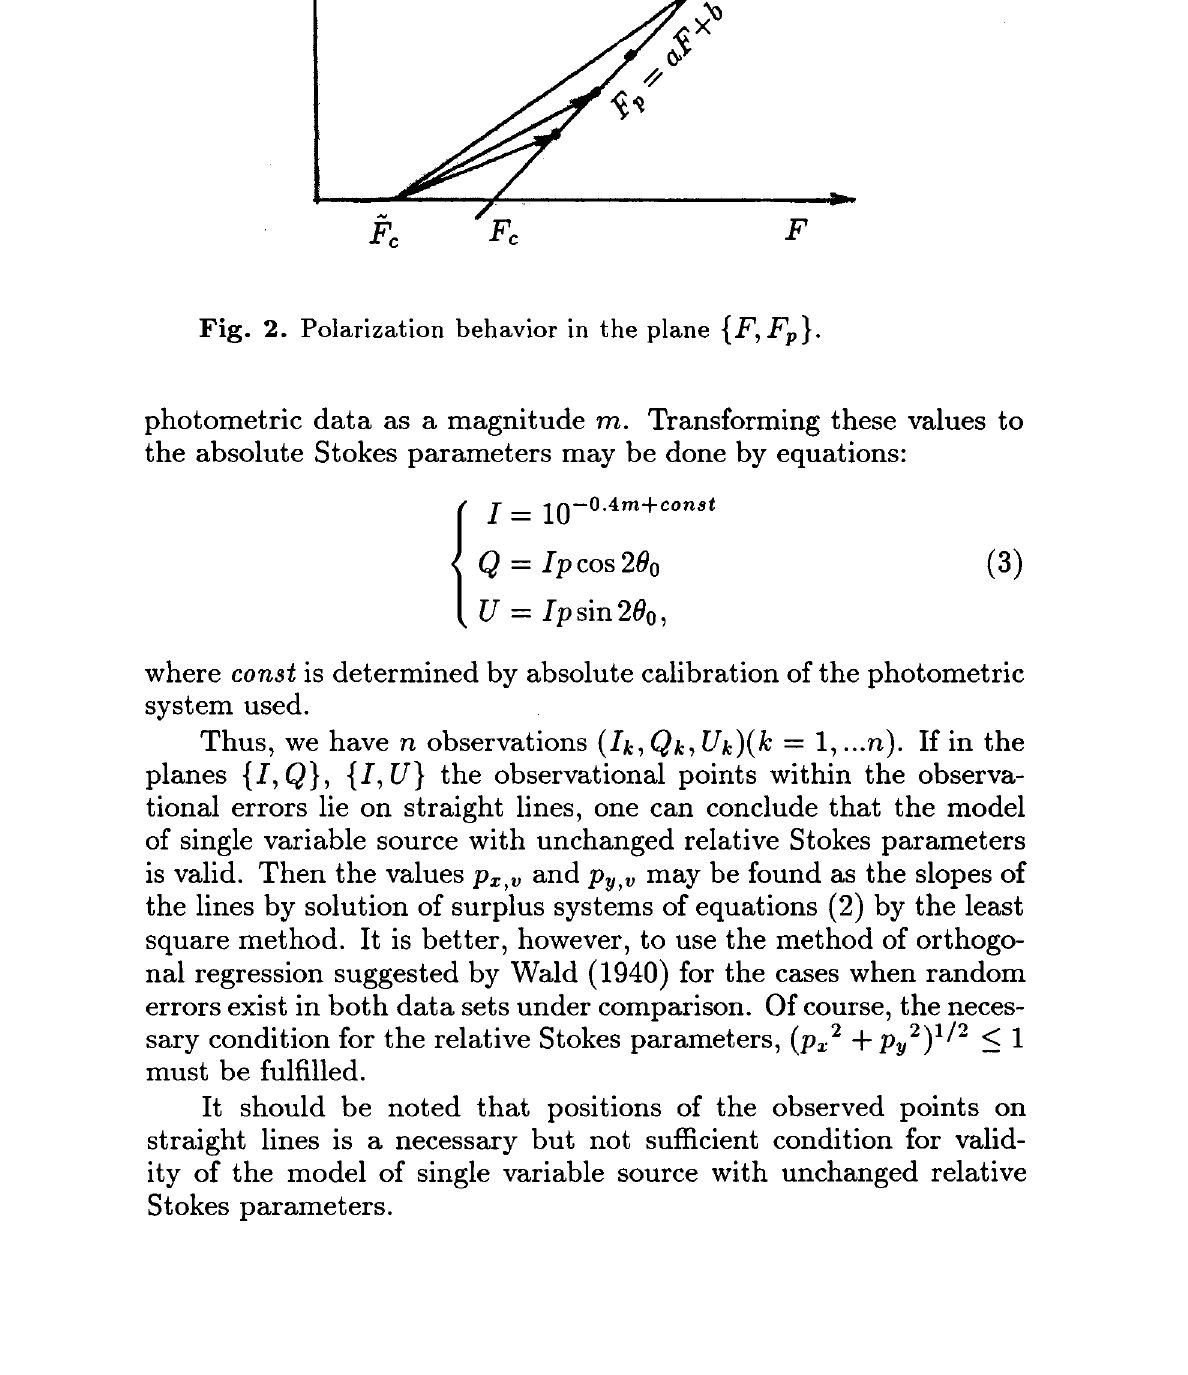
Fig. 2. Polarization behavior in the plane { . F , F p